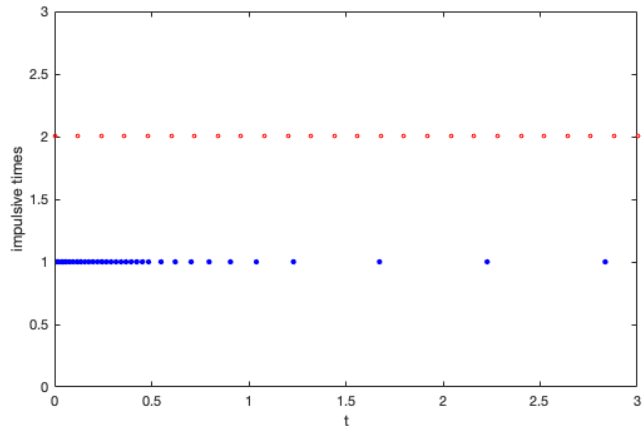
Figure 8. Event-triggered impulsive series under ETM